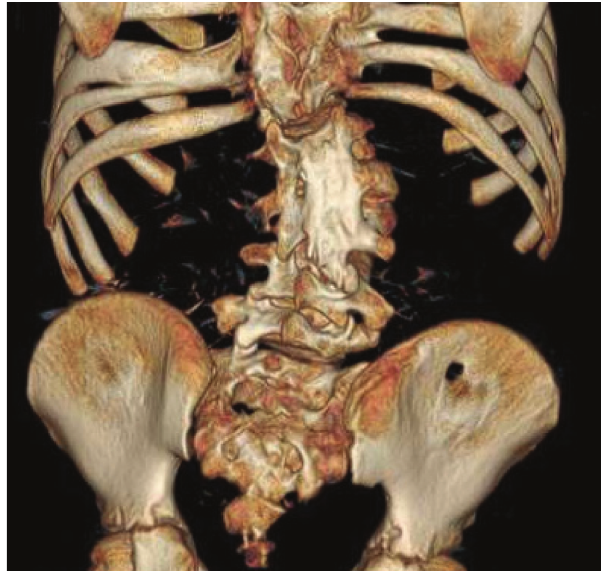
Figure 9 - A 3 D reconstruction CT scan of the lumbar spine in a 15-year-old boy showed a unilateral, posterior unsegmented bar including the upper three lumbar vertebrae associated with fusion of the corresponding spinous processes.